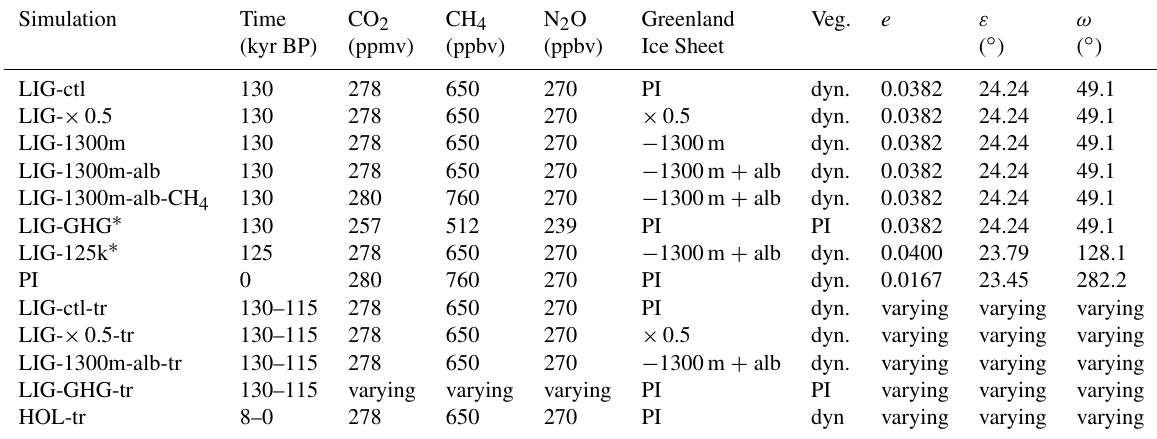
Table 1. Overview of model configuration and climate forcings. PI: pre-industrial; Veg.: vegetation; dyn.: dynamic; e : eccentricity; ε : obliquity; ω : length of perihelion. The Greenland Ice Sheet (GIS) configurations are displayed in Fig. 1.